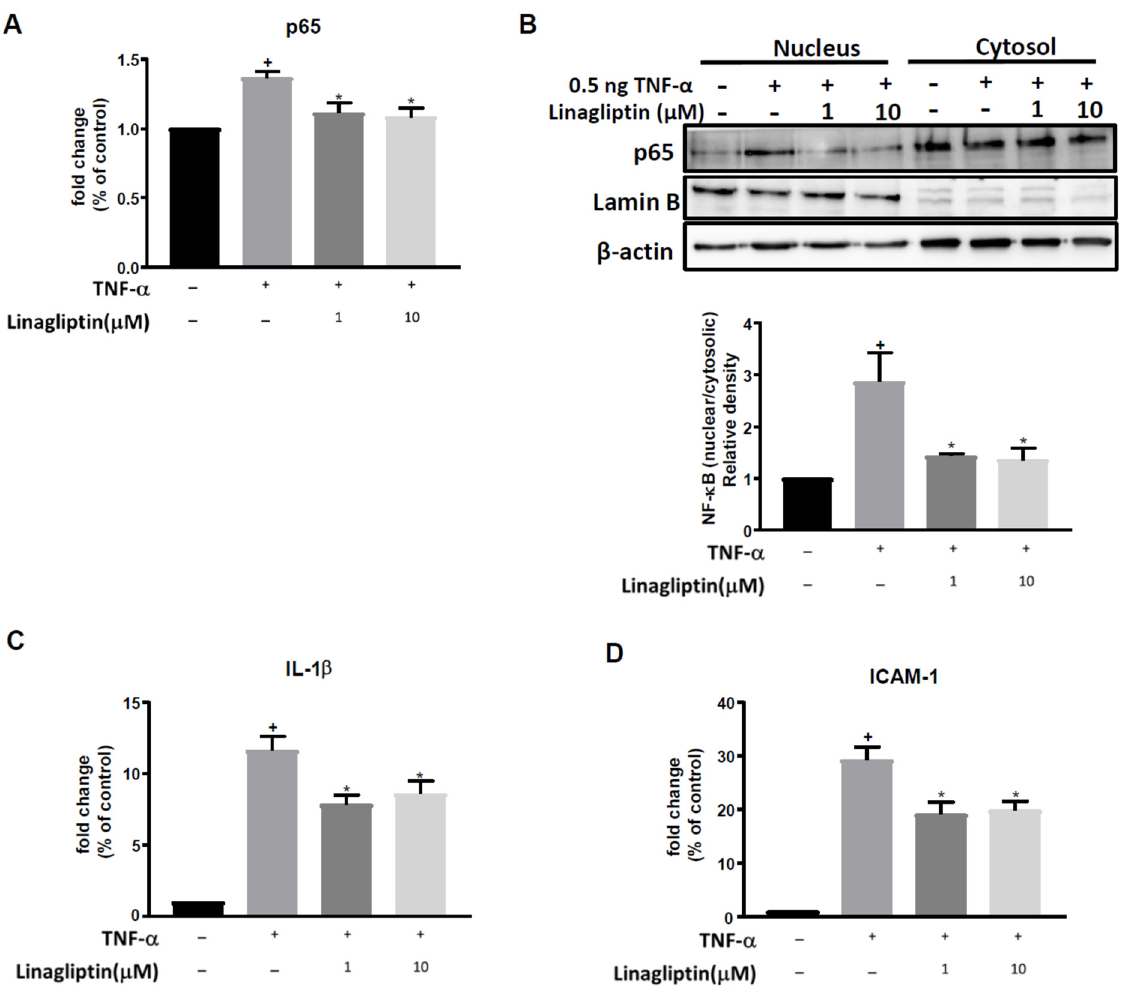
Figure 1. Linagliptin exerts anti-inflammatory effects by suppressing the TNF- α -induced nuclear translocation of NF κ B. HUVECs were pretreated with different doses (1 and 10 µ M) of linagliptin for 48 h and then incubated with 0.5 ng TNF- α for 2 h. ( A ) The expression of NF- κ B p65 subunit mRNA detected by qPCR. ( B ) NF- κ B nuclear/cytosolic protein ratio examined by western blot. ( C ) mRNA expression levels of inflammatory cytokine IL-1 β . ( D ) mRNA expression levels of adhesion molecule ICAM-1. n = 6 in each group. + p ≤ 0.05 compared to control. * p ≤ 0.05 compared to TNF- α -treated cells.